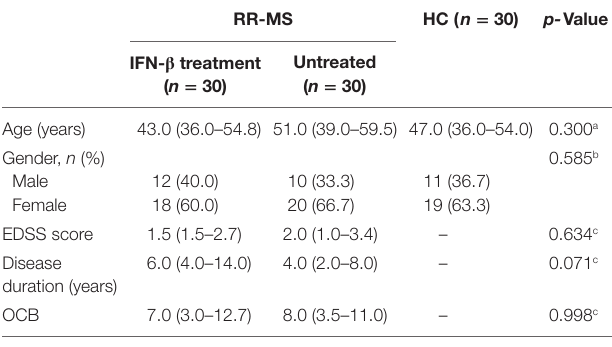
TaBle 1 | Demographic and clinical data of patients with RR-MS and